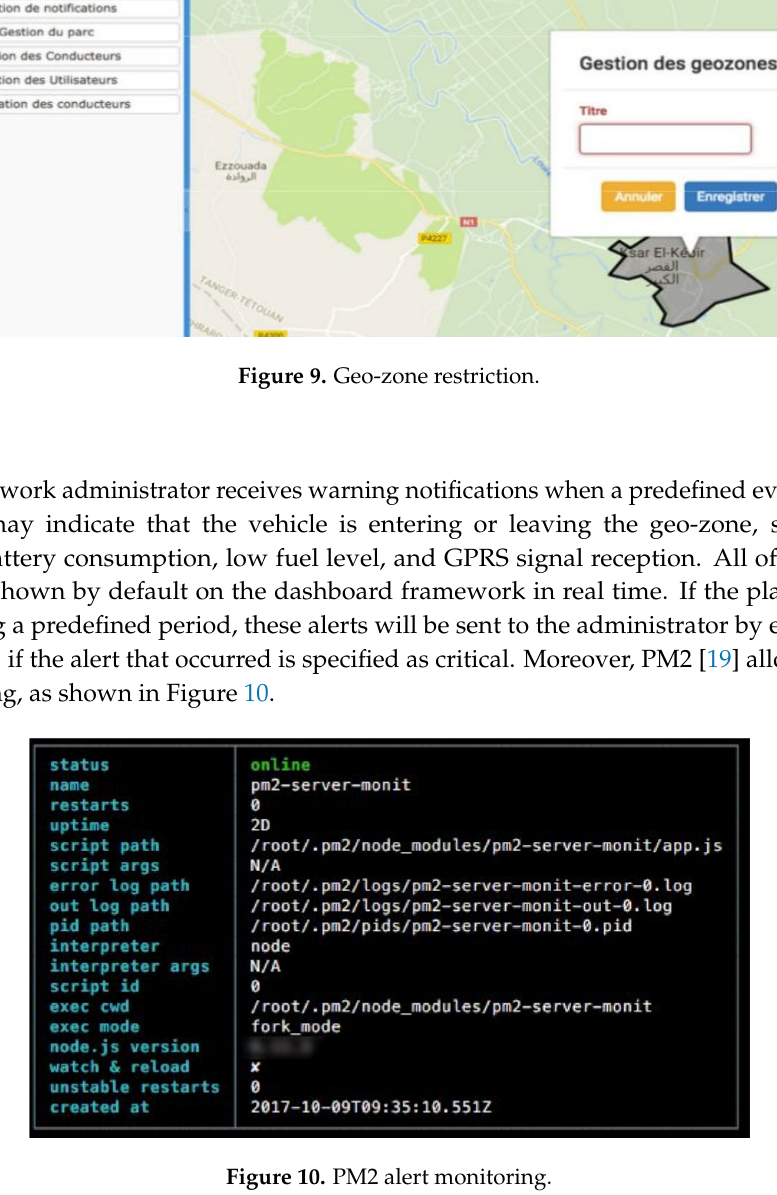
Figure 10. PM2 alert